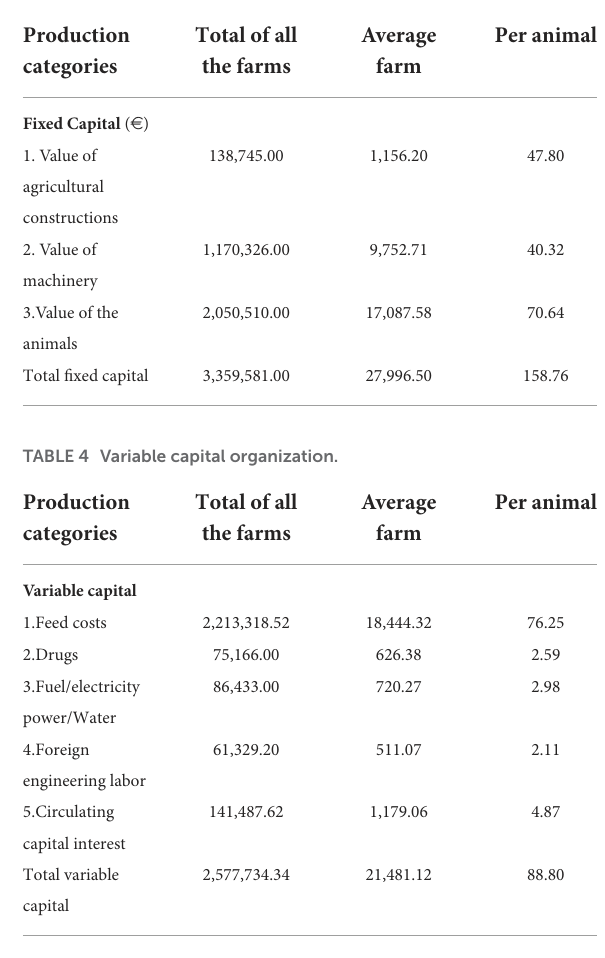
TABLE 3 Fixed capital organization.